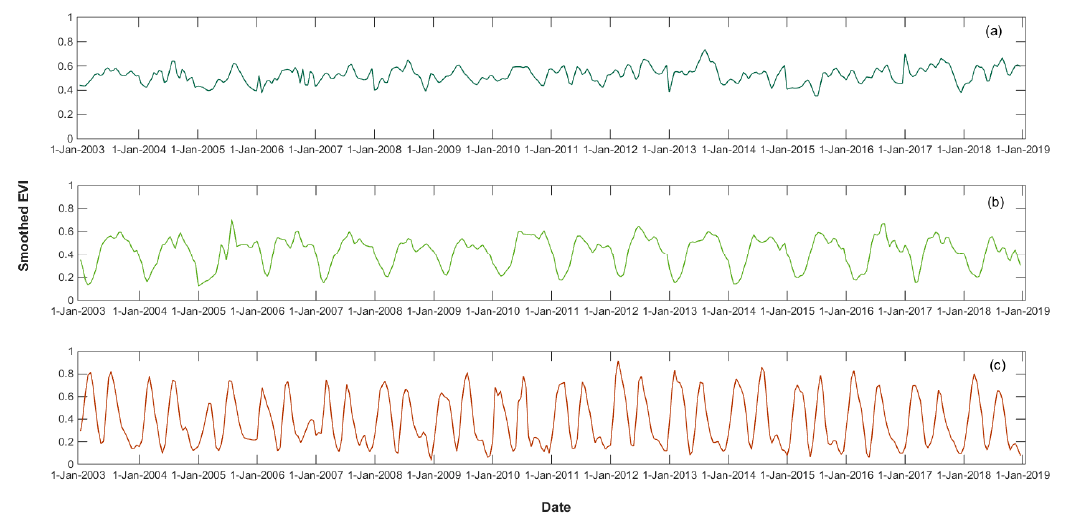
Figure 7. The Savitzky–Golay reconstructed 16-day EVI time series of evergreen forest ( a ), coffee ( b ) and rice ( c ) classes.